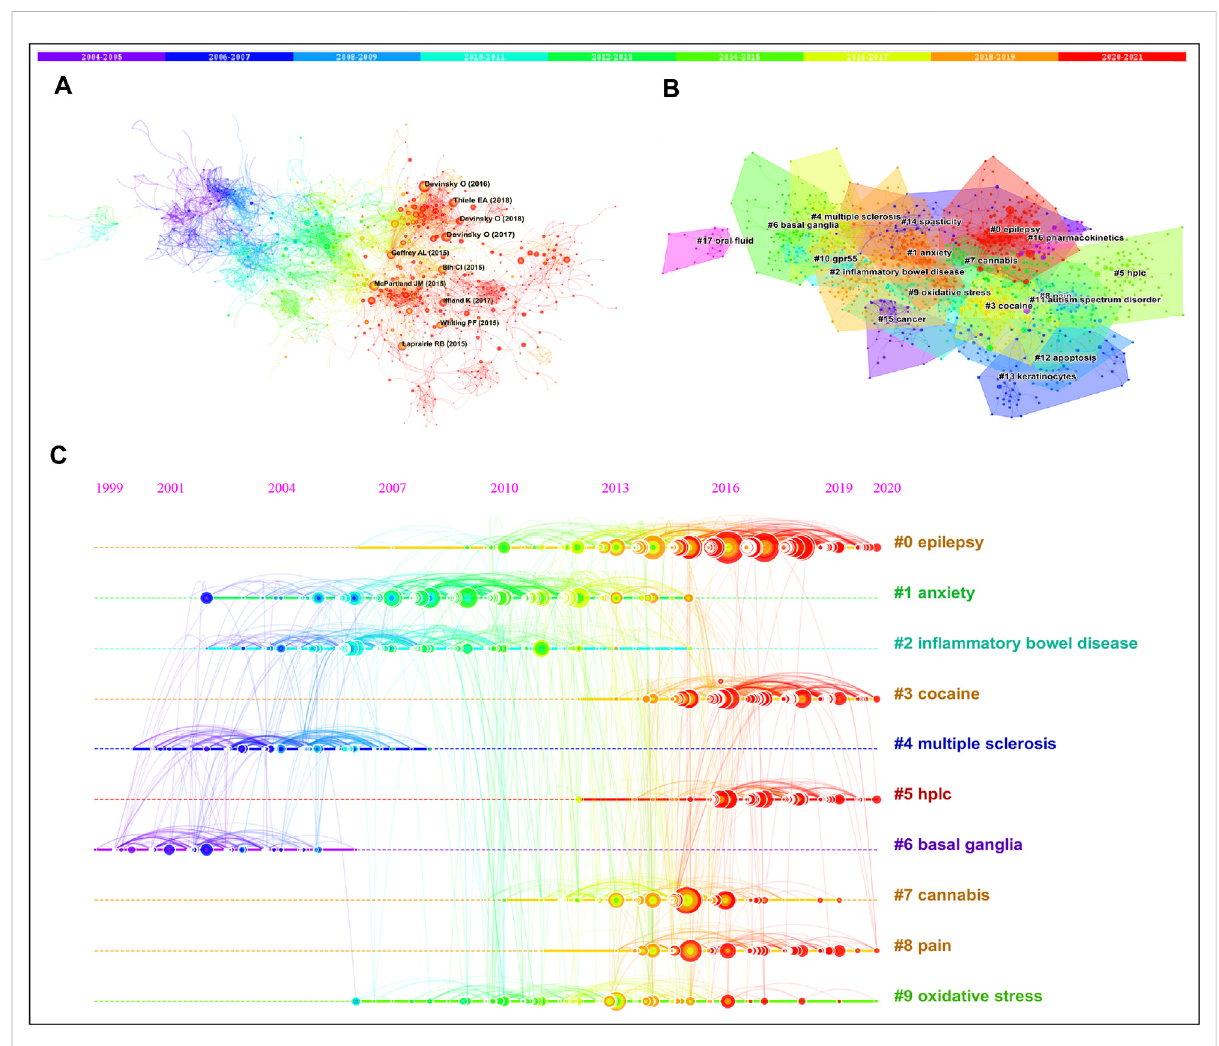
FIGURE 6 Reference co-citation analyses. (A) The network of the co-cited articles. (B) Cluster analysis of the co-cited articles. (C) A timeline view of the top 10